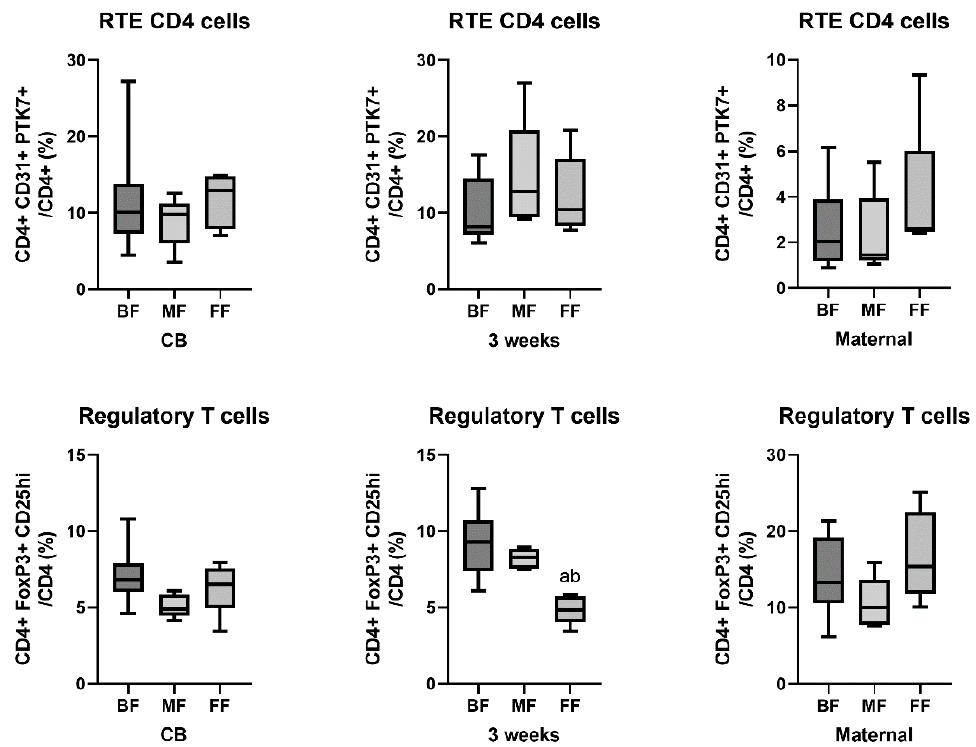
Figure 2. The proportion of recent thymic emigrant (RTE) and regulatory T cells in cord blood (CB) and at three weeks of age in neonates as well as in maternal blood before delivery according to the feeding method (BF — exclusively breastfed ( n = 9), MF — mixed fed ( n = 5), FF — exclusively formula fed ( n = 5)). p < 0.05 vs. a — BF, b — MF. Line — median, box — quartiles, whiskers — range.